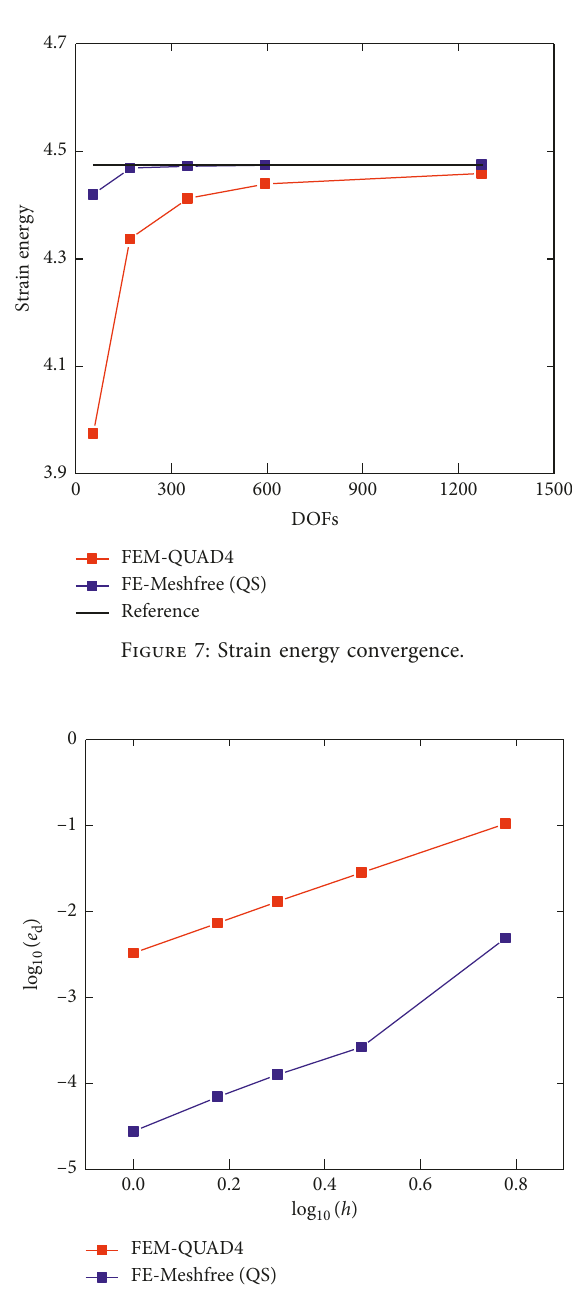
Figure 8: Convergence rate of displacement error norms. Figure 6: Deflection of point A for irregular mesh.